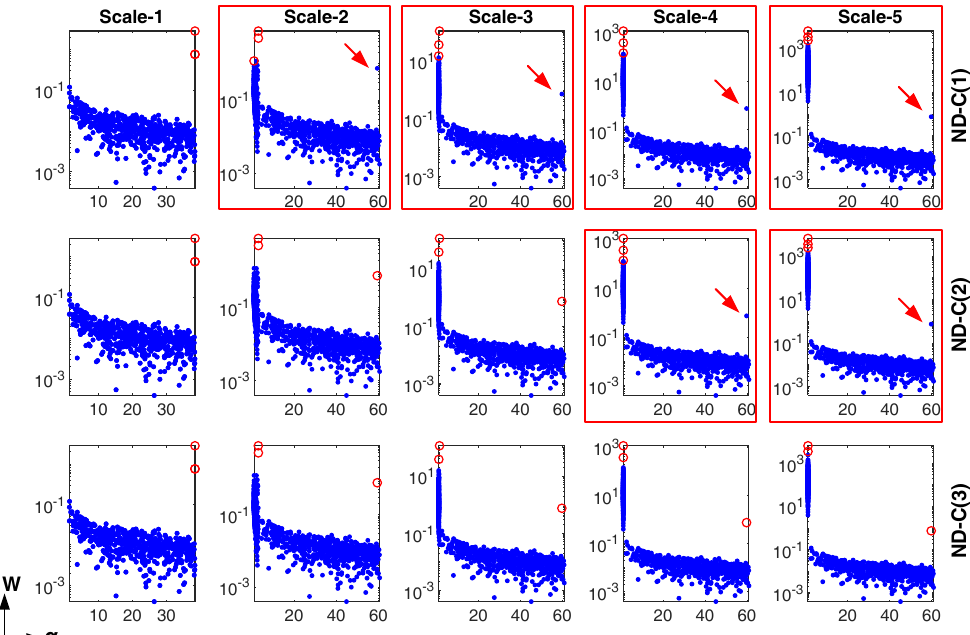
Figure 13. The 2-classification Decision Diagrams of ND-C(1), ND-C(2), and ND-C(3) on the first five scale-different datasets shown in Figure 10. The red rectangles mark the 2-classification Decision Diagrams with falsely classified points, which are in blue and pointed by the red arrows . For each sub-graph in the first column, there are actually three circles, two of which are